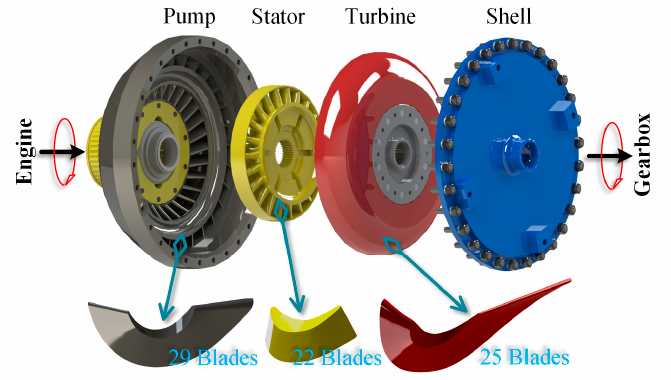
Figure 1. A basic model of hydraulic torque converter.